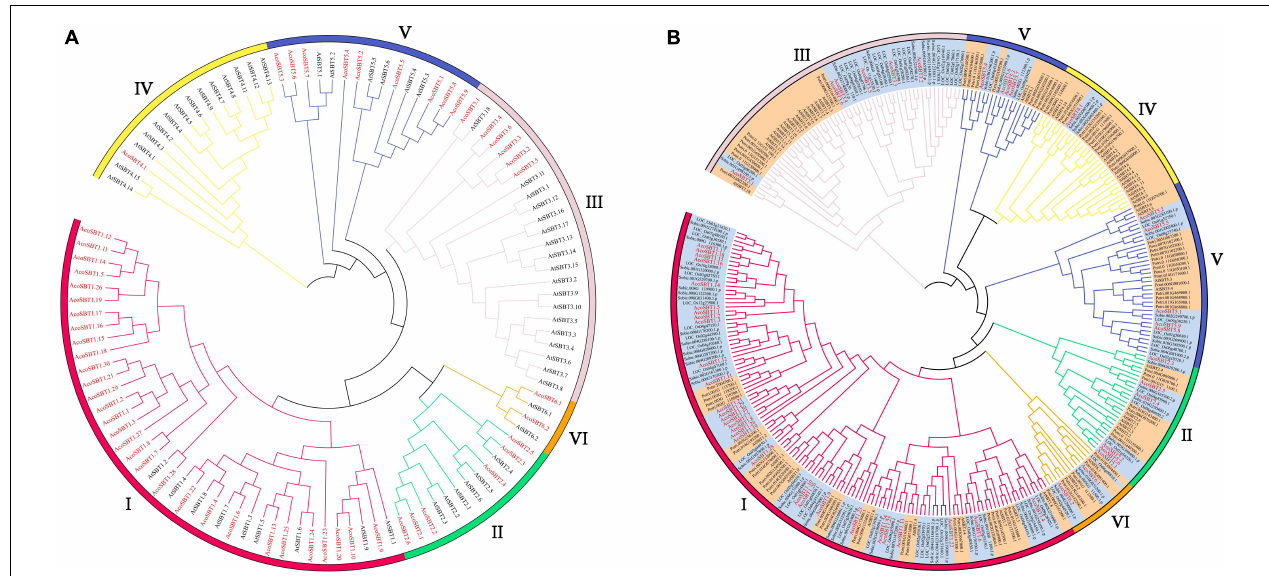
FIGURE 1 | The evolutionary relationship of SBTs. (A) Phylogenetic relationship of the SBT proteins of Aco (Pineapple), At ( Arabidopsis thaliana ). (B) Phylogenetic relationship of the SBT proteins of Aco, At, Potri ( Populus trichocarpa ), Os ( Oryza sativa ), and Sbicolor ( Sorghum bicolor ). The phylogenetic tree was generated using neighbor-joining with 1,000. The phylo-genetic tree divides SBTs into six subfamilies, and the subfamilies are represented with different colors. Members from monocotyledonous plants are highlighted in orange while genes from dicotyledonous plants are highlighted in bright blue. SBT members from pineapple are marked in red